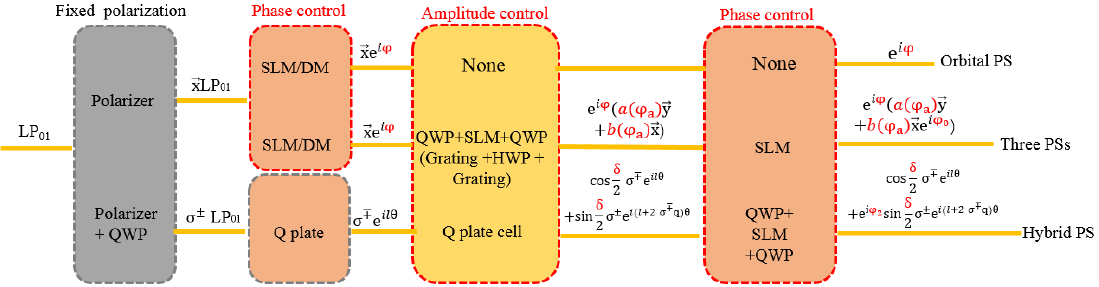
Figure 6. The flow chart of tunable OAM generation by adjusting the phase distributions on the spatial light modulators (SLMs), deformable mirrors (DMs) and q-plate cells.